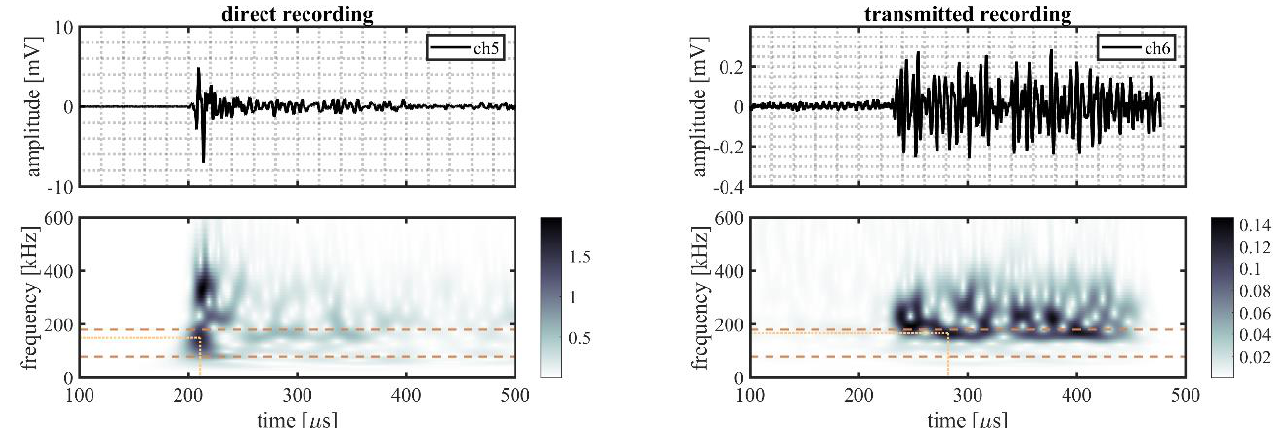
Figure 8. Randomly selected event recorded by R15I-AST sensors, originating from a source location S22, showing the time traces recorded on the outer raceway (ch5, top left ) and on the inner raceway (ch6, top right ), and the time – frequency representation of the recorded signals on the outer ( bottom left ) and the inner ( bottom right ) raceways. The detected magnitude in the time – frequency repre- sentations of the signals is indicated by the intersection of the dotted lines; the dashed lines indicate the frequency range of interest (80 – 180 kHz).